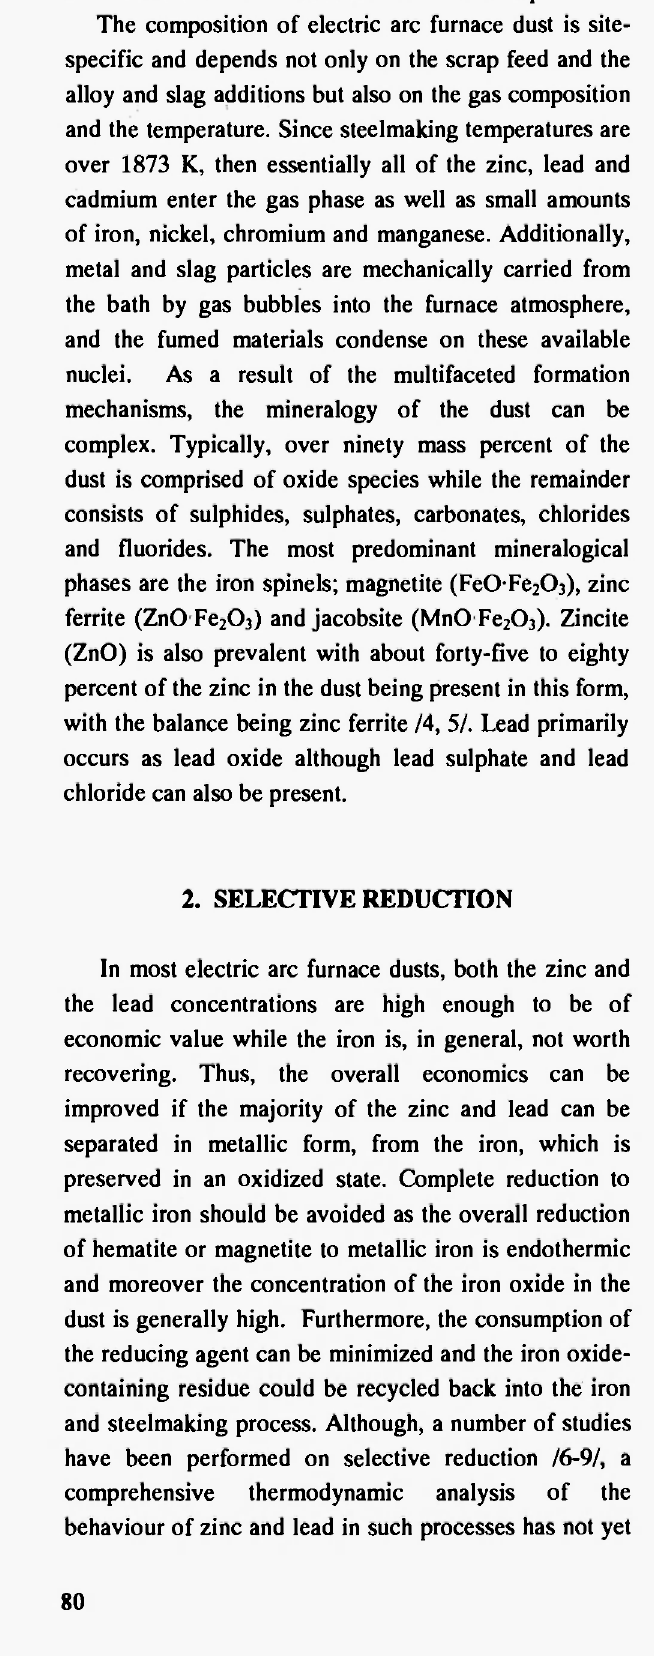
Fig. 1: Standard free energy changes for the reduction of the various iron oxides, zinc oxide and lead oxide by carbon monoxide as a function of temperature from 1273 Κ to 1873